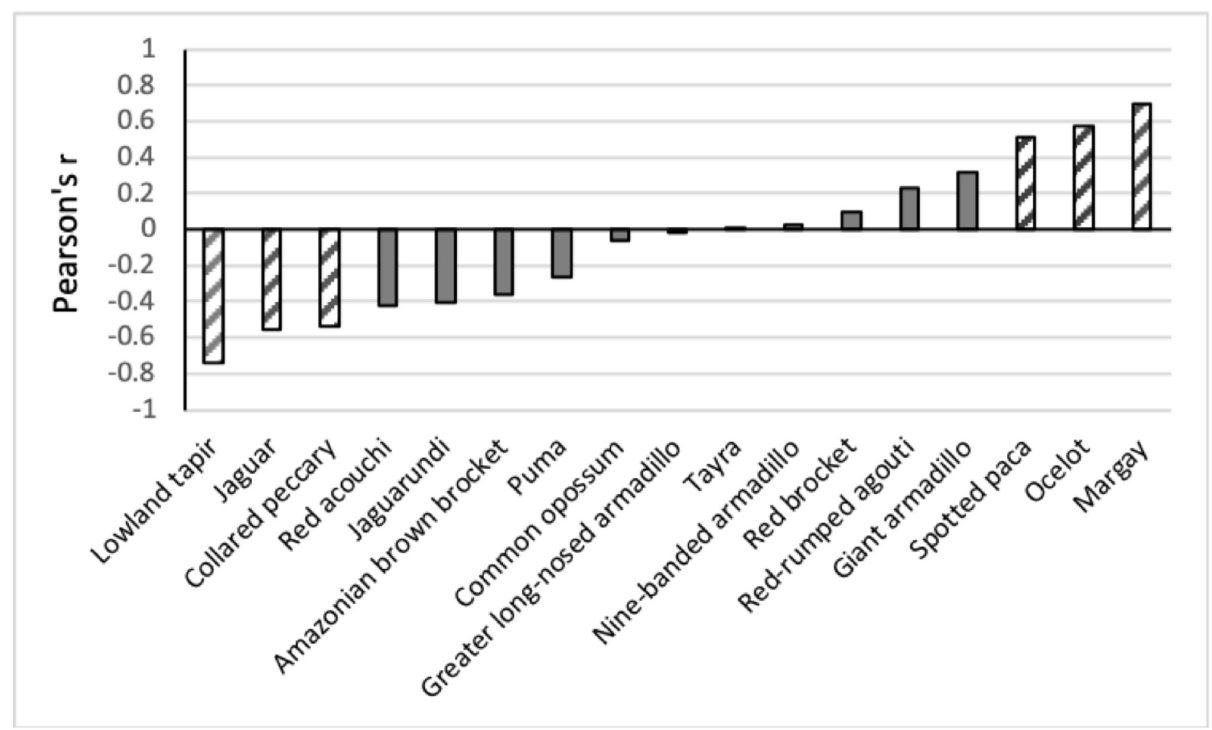
Fig 4. Pearson correlation (r) between the annual number of tourist triggers per camera site and various mammal species. Solid gray—r is not significant (p > 0.05); striped-gray bars—r is significant (p < 0.05).